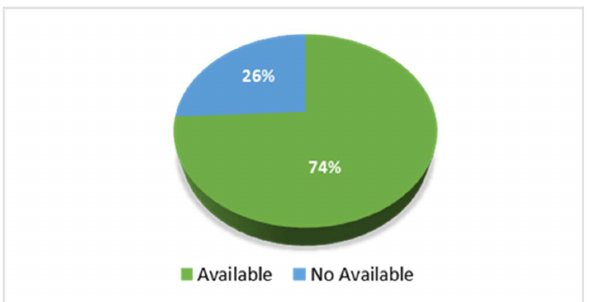
Figure 5. Tools distribution analysis.